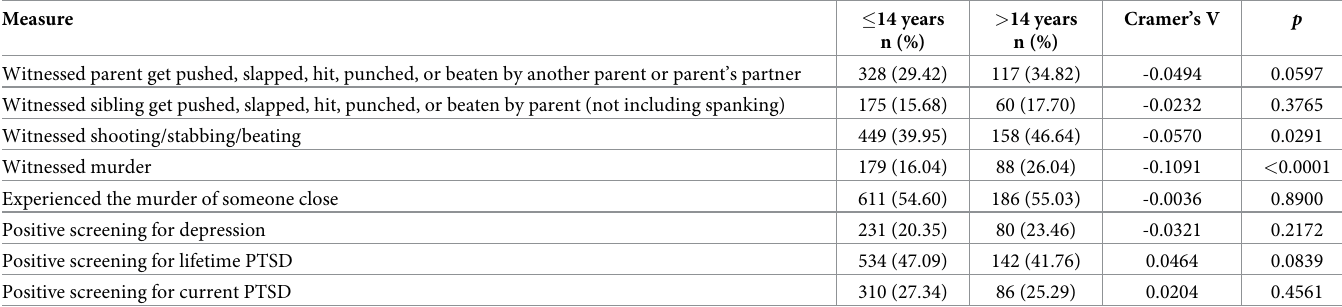
Table 3. Indirect exposure to violence and adverse mental health symptomatology by age group (N = 1548). Measure � 14 years